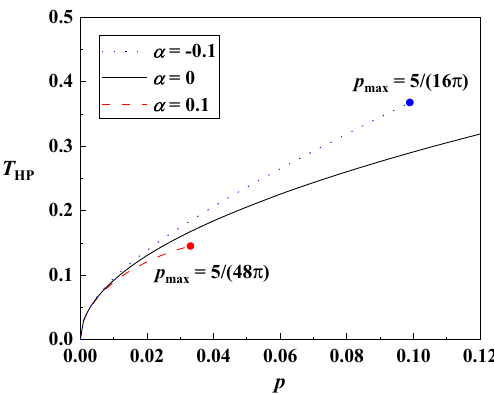
Fig. 4 TheHPphasetransitiontemperatureoftheSchwarzschild–AdS black holes with the GB term as a function of pressure. At a fixed pressure p , T HP decreases with α . There is an upper bound of p , p < 1 /( 96 πα) for positive α or p < − 1 /( 32 πα) for negative α , resulting in the terminal points in the coexistence